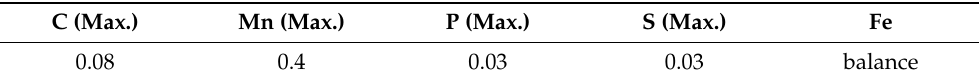
Table 1. Chemical composition of DC04 in accordance with the requirements of EN 10130: 2006 (in wt.%).